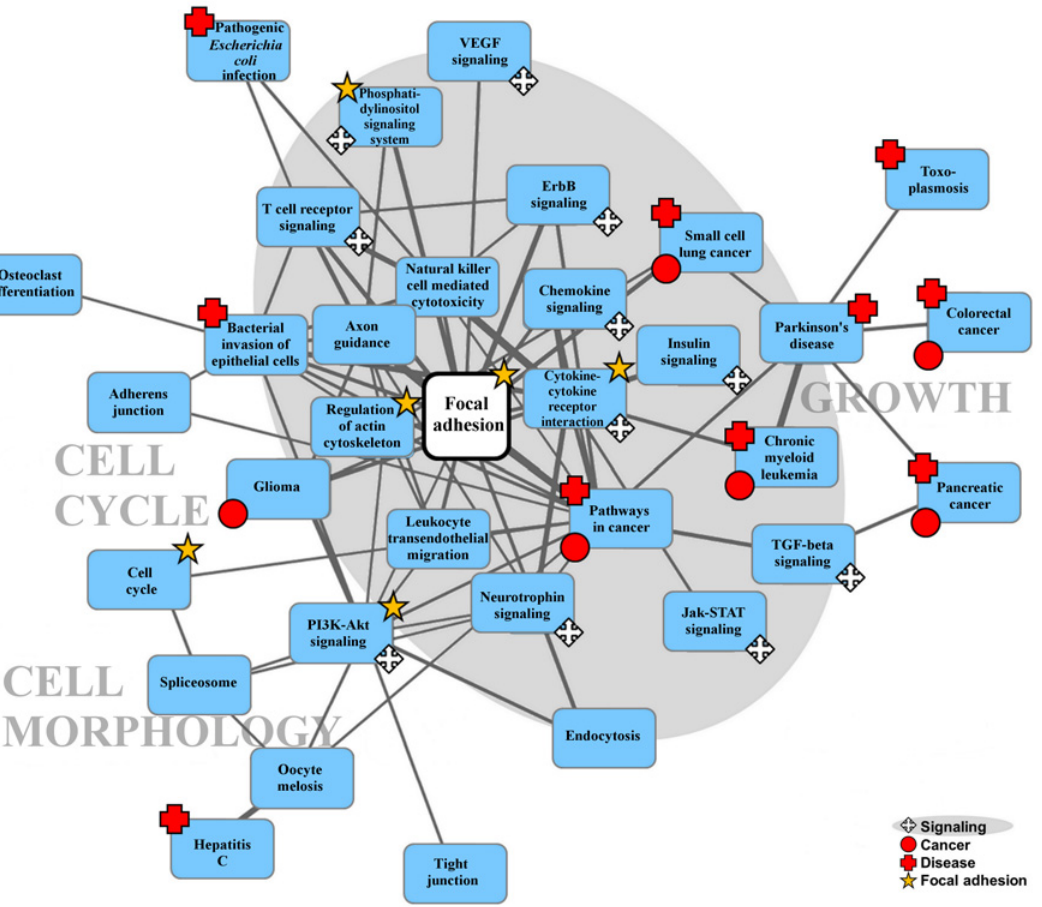
Fig 6. Focal adhesion as a central hub for targeting host cells. The number of shared protein-protein interactions (PPIs) targeted by B. mallei virulence factors is shown as lines proportional to the number of PPIs (only connections with 10 or more interactions are illustrated). Physiological, cancer, and disease pathways were all interconnected via signaling pathways that could be affected through the focal adhesion